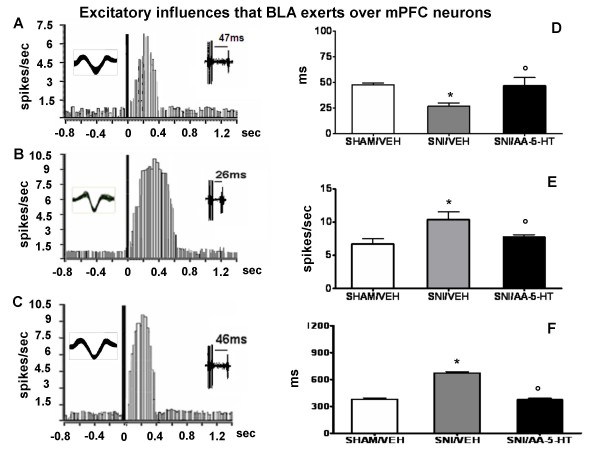
BLA stimulation evokes excitatory responses in the PL/IL cortex of BLA → PL/IL (+) neurons. The figure shows different parameters of BLA-evoked excitation, including the onset, the frequency and the duration of excitation, in sham and SNI rats treated for 7 days with vehicle (veh) or AA-5-HT (5 mg/kg, i.p.). "A", "B" and "C" show a representative ratemater record of a BLA → PL/IL (+) neurons of sham/veh, SNI/veh and SNI/AA-5-HT rat. "D","E" and F show the onset, onset, the frequency and the duration (mean ± SEM) of the excitation, respectively, in the different groups of rats. * indicates statistically significant difference versus sham/veh and º versus SNI/veh. P < 0.05 was considered as value of significance and n = 10 was used for each group.